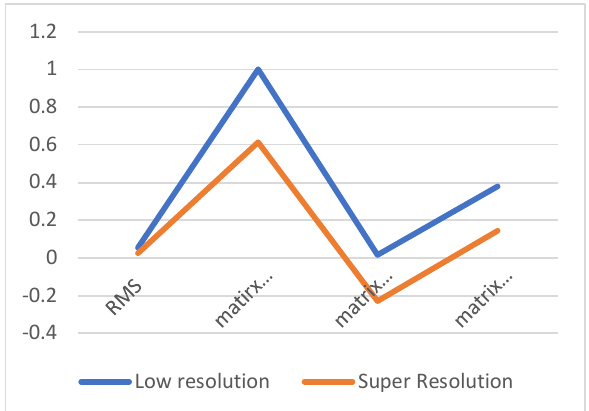
Figure 14: RMS [m] and matrix transformation both low and super resolution images for portal.